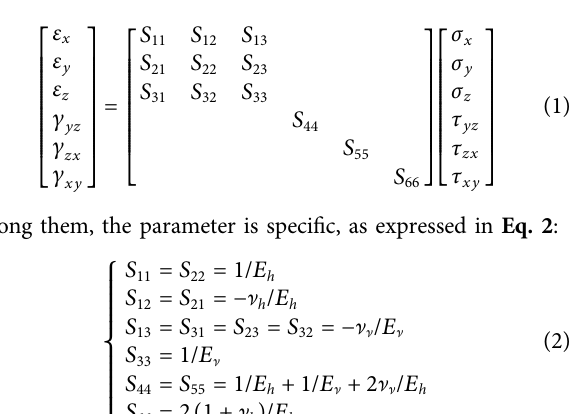
FIGURE 6 | Fitting of compressive strength data before and after